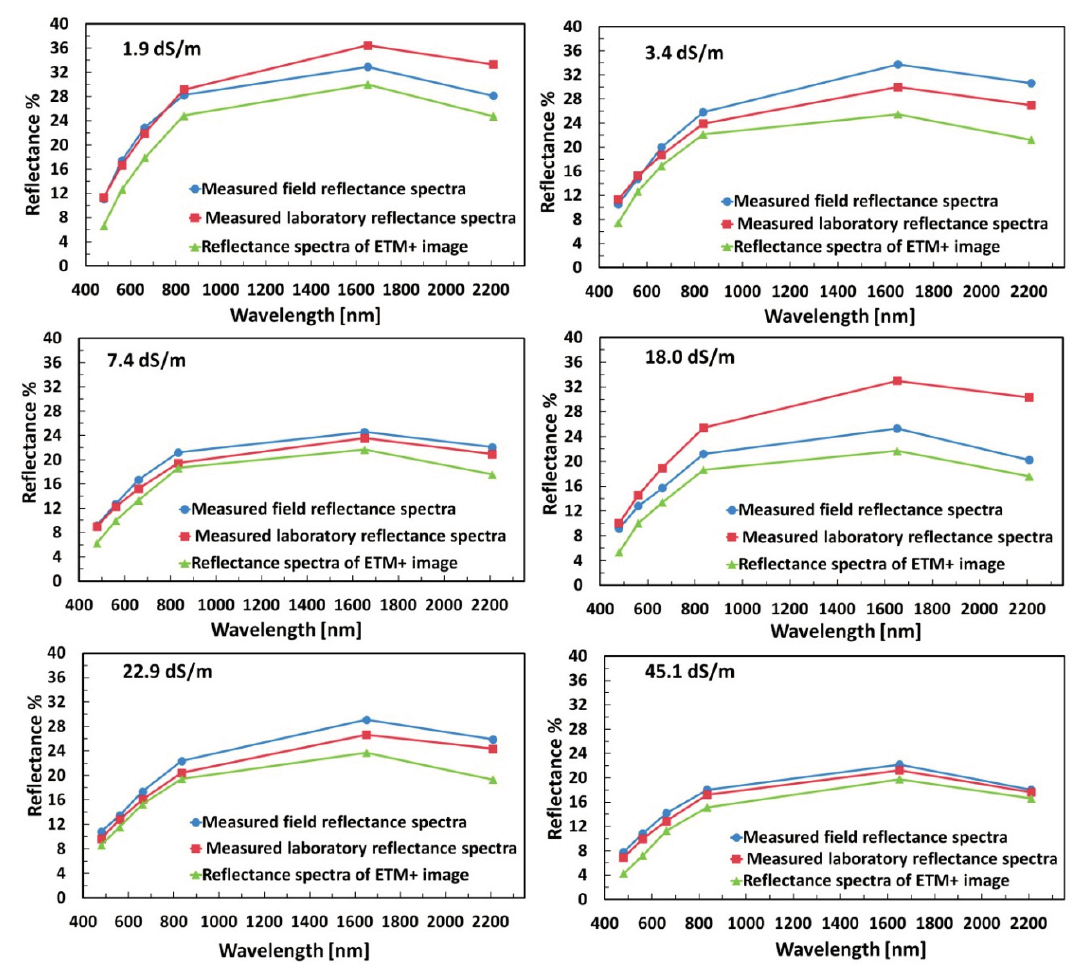
Figure 3. Comparison of the field-measured, laboratory, and Landsat 7 ETM+ spectral reflectance of soil samples with different salinity values (EC e